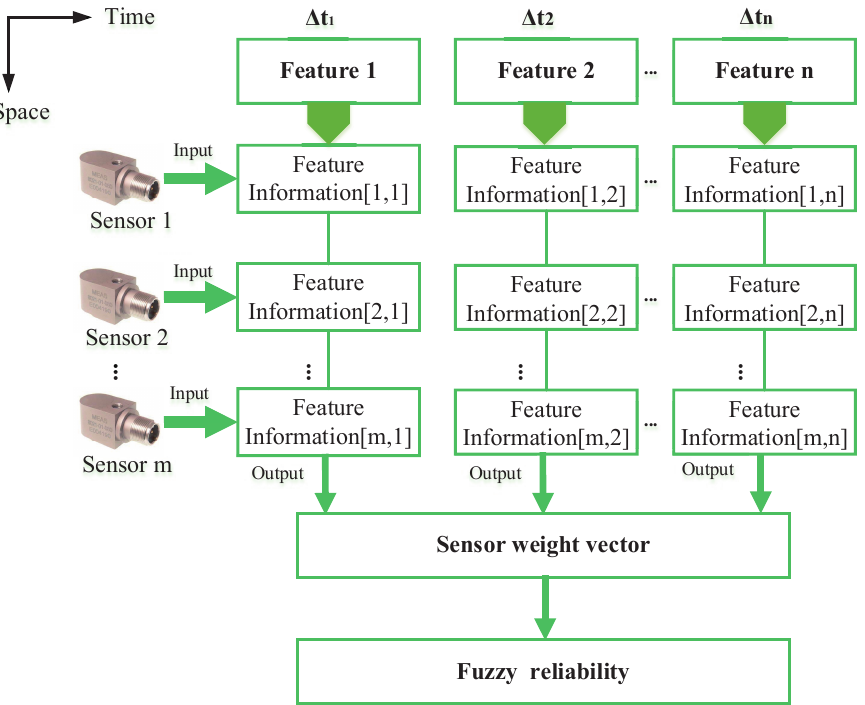
Figure 3. The procedure of modeling component B (reliability) of sensors.